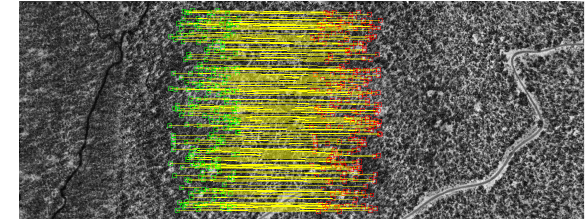
Figure 13: Matches for SIFT using intensity